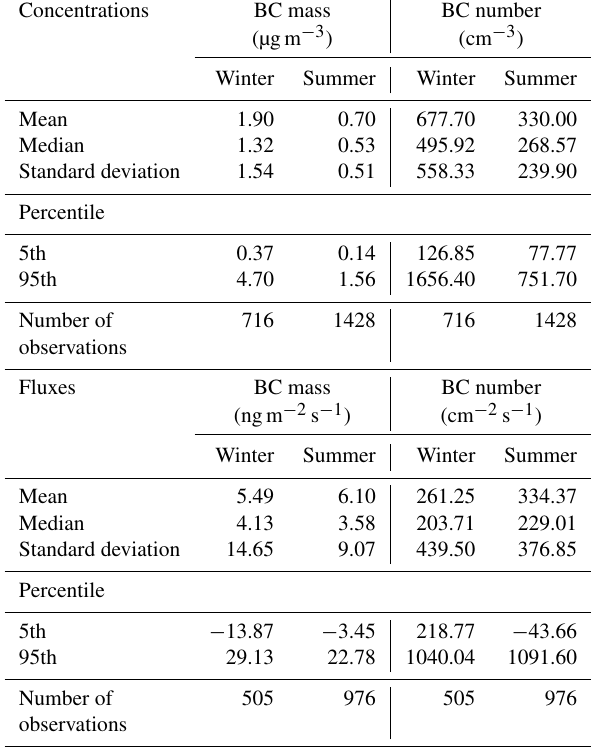
Table 1. Concentration and flux statistics of BC measurements at the IAP tower. The 5Hz concentration measurements were resam- pled 30min before performing statistical calculations.